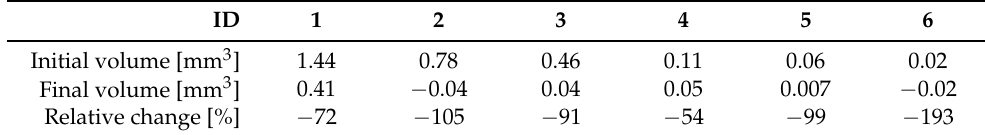
Table 1. Estimated colony volume change before and after the picking